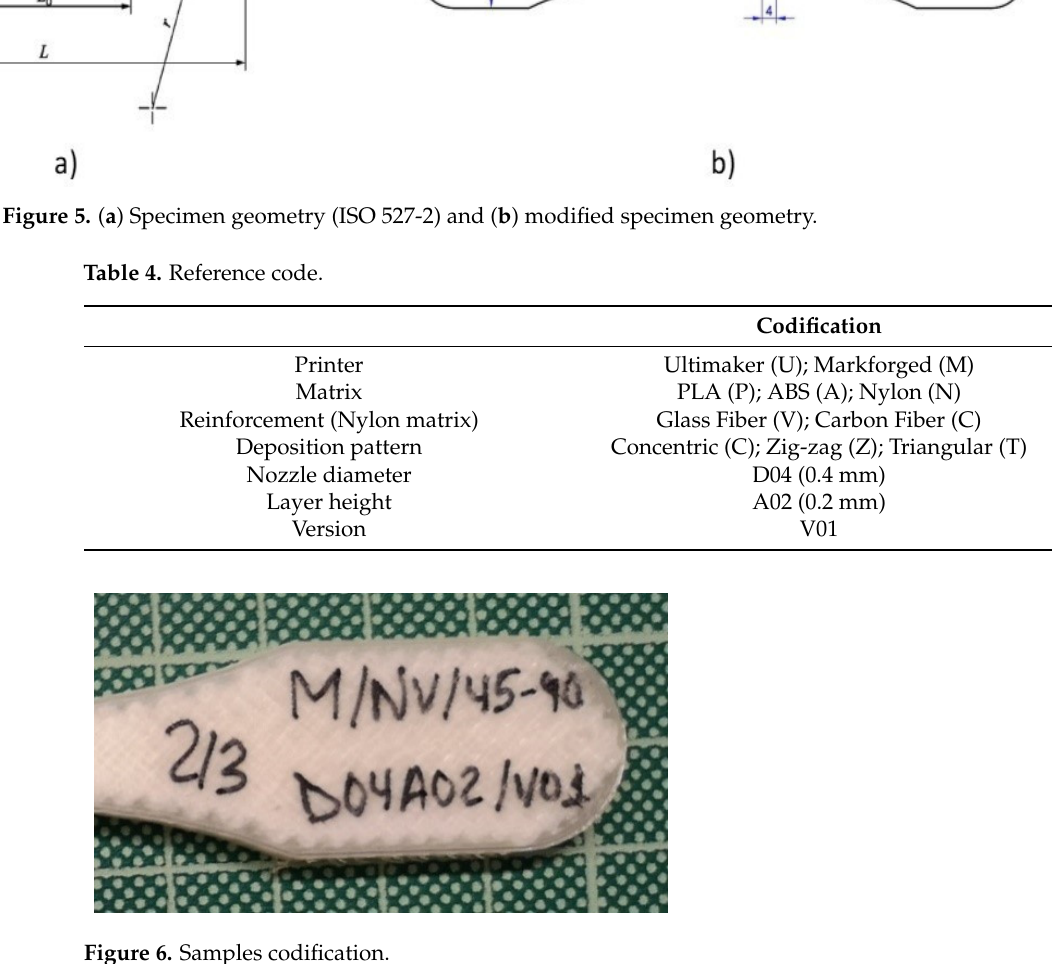
Figure 7. Servosis ME-405 machine and tensile test performance. The stress-strain curves ( σ - ε ) have been obtained from the data provided by the test software, determining the tensile stress at yield by fitting the curve to a straight line with offset 0.2% strain. 3. Results and Discussion 3.1. Results The results obtained from the tensile tests performed on the set of specimens made with additive manufacturing using Fused Filament Fabrication are shown in this section. Table 5 lists the average values for the main mechanical properties, as determined in the tensile tests, including the tensile modulus, yield strength, tensile strength at break, and elongation Next figures show the evolution of the different parameters according to each depo- sition patterns and material of this experience (Figures 8 − 10, 12, 14, 16, 21, and 26) as well as the specific behavior of certain specimens (Figures 11, 13, 17 − 19, and 23 − 25).